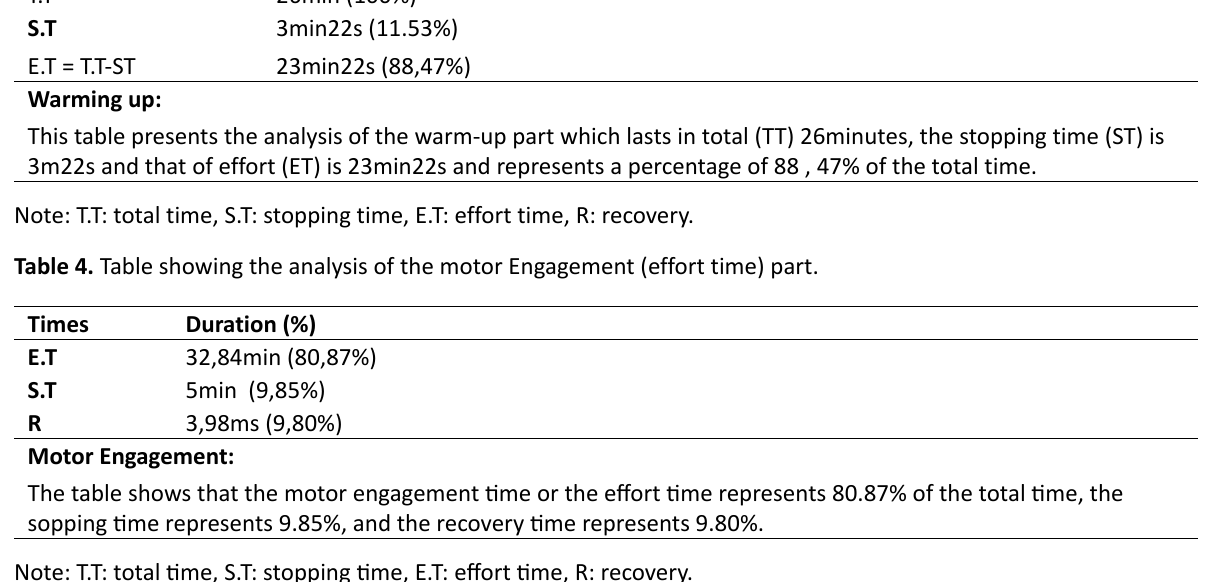
Table 3. Table representing the analysis of the warm-up part Times